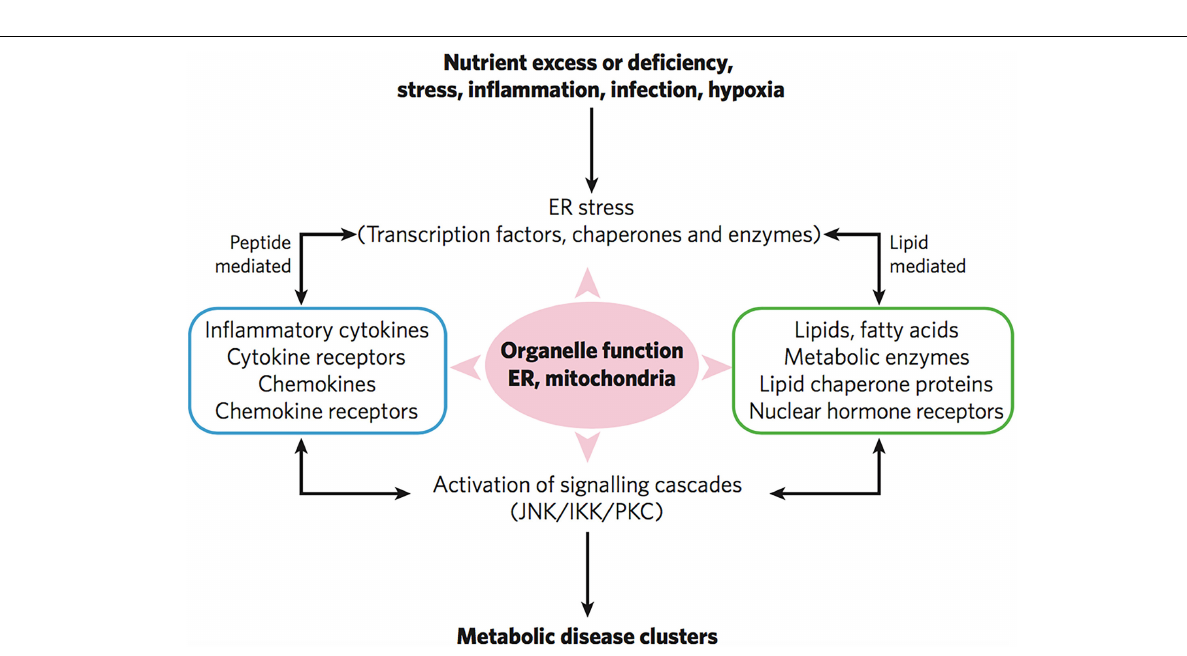
Frontiers in Cell and Developmental Biology |